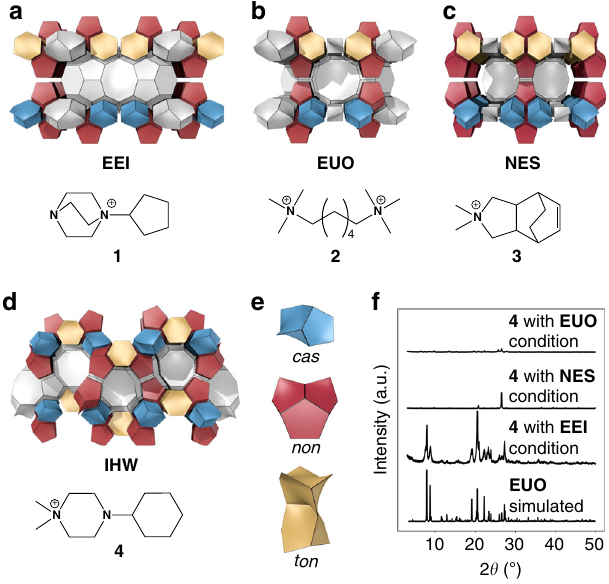
Fig. 6 Crossover synthesis experiments for EEI , EUO , NES , and IHW . a – d Crystal structures of EEI ( a ), EUO ( b ), NES ( c ), and IHW ( d ) with typical OSDAs ( 1 – 4 ) used for their syntheses. e Building units ( cas , non , and ton ) found in the four structures. f Powder XRD patterns of the products synthesized using 4 as an OSDA under the typical synthesis conditions for EEI , EUO , and NES (see Supplementary Table 8). Thermogravimetric analysis con fi rmed that a single OSDA was occluded in the cage of the